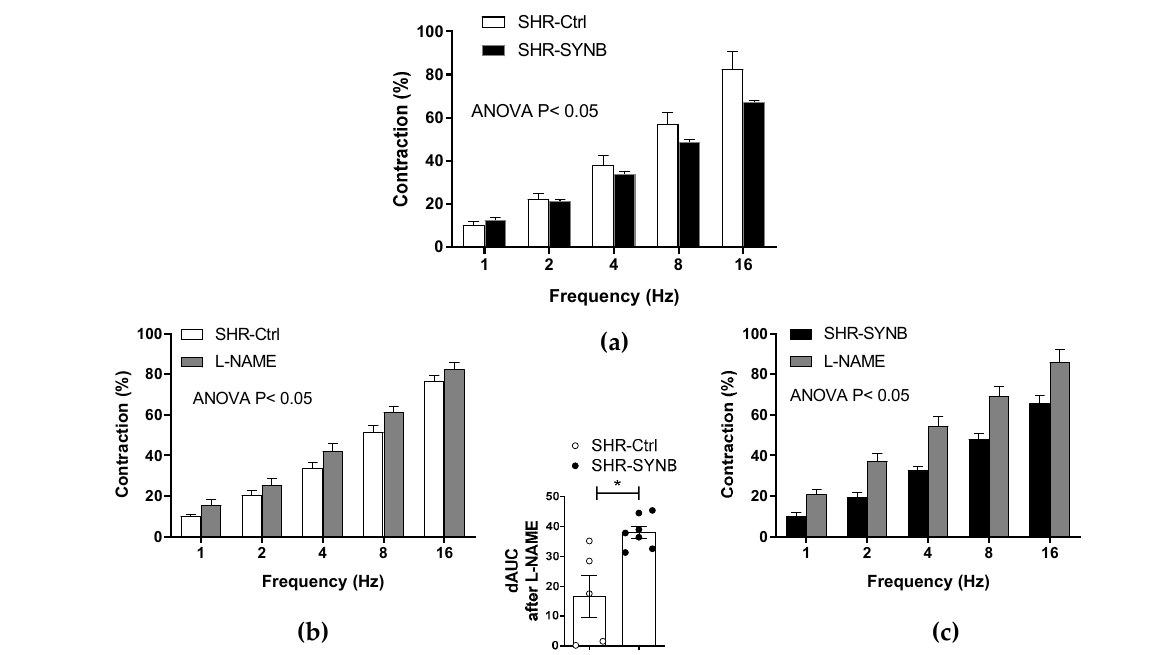
Figure 3. ( a ) Vasoconstriction induced by electrical field stimulation (EFS) in endothelium-denuded mesenteric segments from SHR-Ctrl and SHR-SYNB animals ( n = 6–8 segments from different rats in each experimental group). Results (mean ± S.E.M.) are expressed as a percentage of the previous tone elicited by KCl. Analysis of the functional role of neuronal NO on EFS-induced vasoconstriction by preincubation with the unspecific nitric oxide synthase (NOS) inhibitor L-NAME, in mesenteric arteries from SHR-Ctrl ( b ) and SHR-SYNB ( c ). Results (mean ± S.E.M.) are expressed as a percentage of previous tone induced by KCl. n = 5–6 segments from different animals in each experimental group. Insert panel: Differences in the area under the curve (dAUC) in presence/absence of L-NAME. * p < 0.05 SHR-Ctrl vs. SHR-SYNB (Student’s t -test).